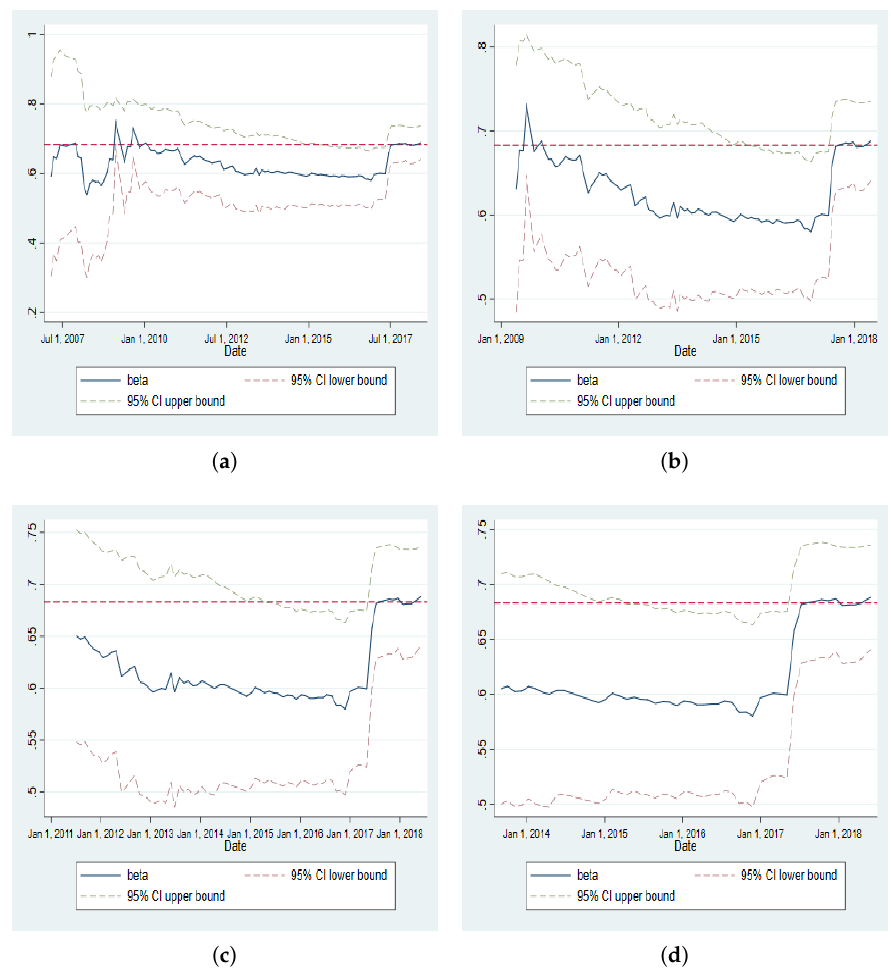
Figure A9. Dynamics of the persistence parameter for the BRVM10 index using recursive rolling regression. These graphs plot the persistence parameter estimated using rolling regression. The date is the end date for a selected window. In ( a ), the persistence parameter is around 0.6 using recursive rolling regression with a window whose end date is 1 July 2007. The dot lines denote the 95% level confidence interval. ( a ) Dynamics of the persistence parameter using rolling regression with a 2-year window; ( b ) Dynamics of the persistence parameter using rolling regression with a 4-year window; ( c ) Dynamics of the persistence parameter using rolling regression with a 6-year window; ( d ) Dynamics of the persistence parameter using rolling regression with an 8-year